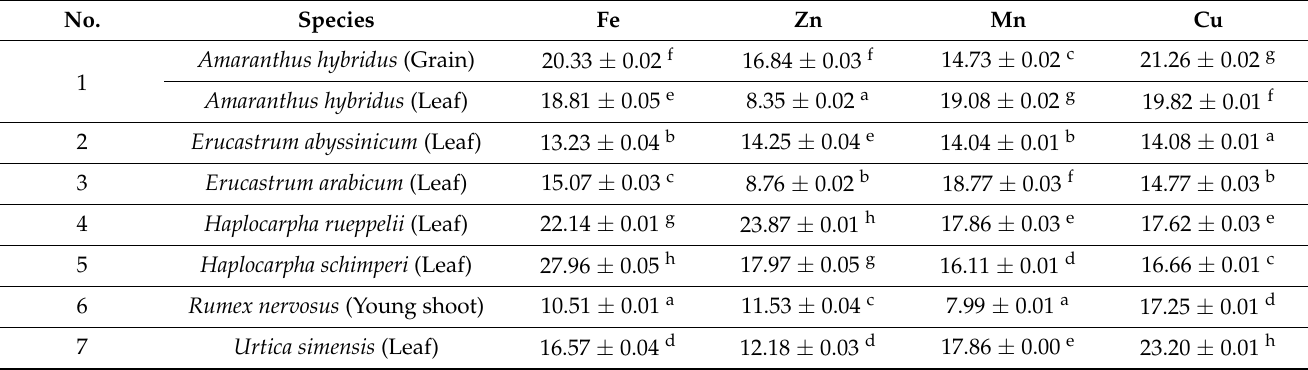
Table 3. Micronutrient contents of selected wild edible plants (mg/100 g